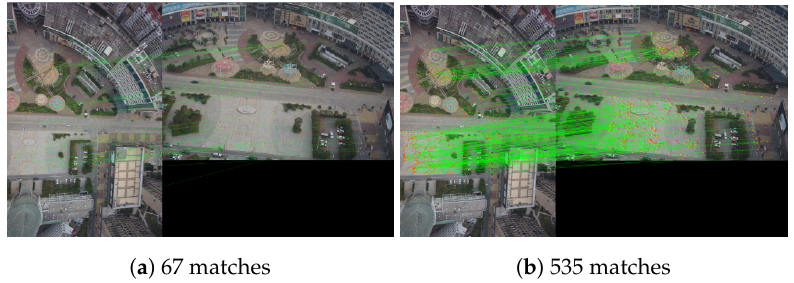
Figure 9. Feature matching of one image pair from dataset 3: ( a ) without the tiling strategy; ( b ) with the tiling strategy.